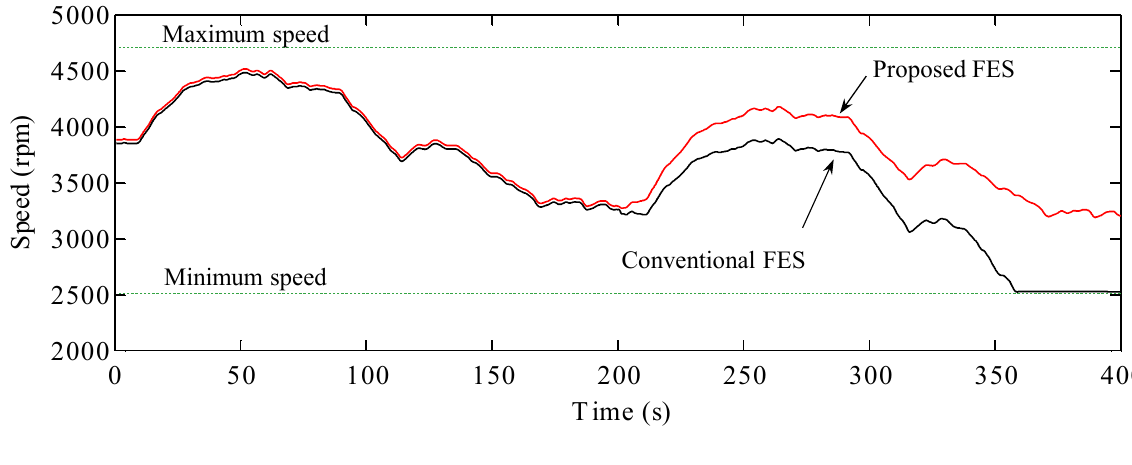
Figure 16. Speed of the FES